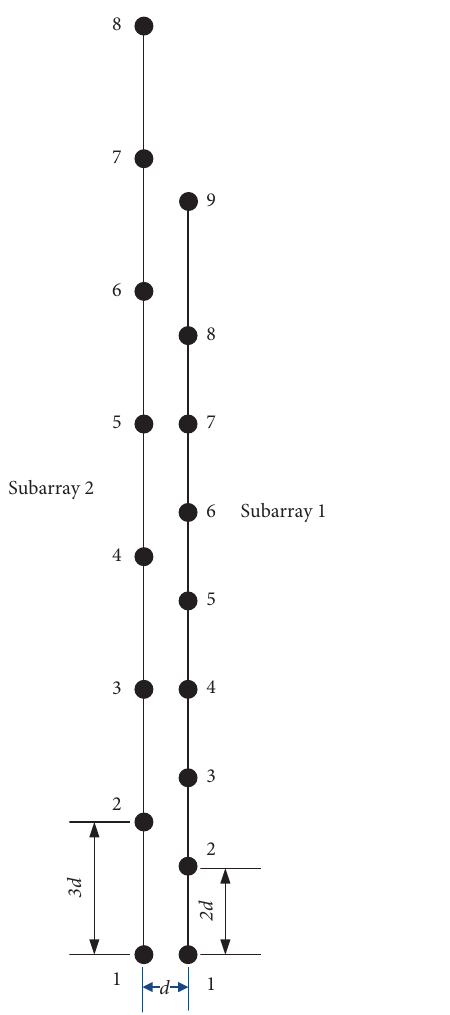
Figure 2: Two uniform large-spacing parallel linear arrays ( q � 2).